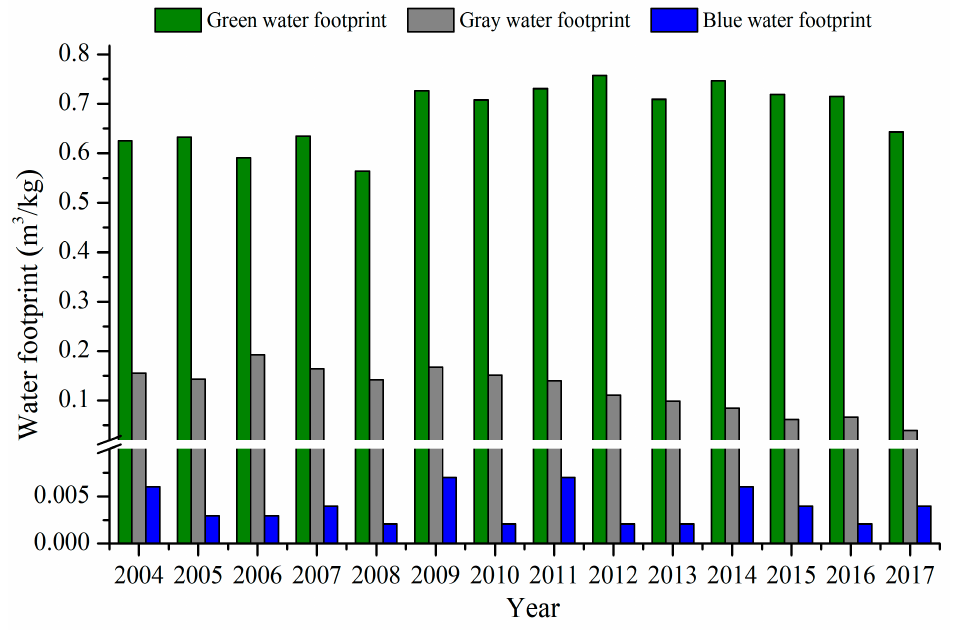
Figure 6. Blue, green and gray WFs of maize production from 2004 to